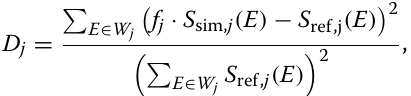
interactions were processed with this CIE map to form an initial spectrum (Eq. 7), the energy calibration parameters were determined, and the energy calibration and resolu- tion applied. The energy resolution parameters were optimised separately from the CIE parameters (inner loop in Fig. 3), as the generation of a new CIE map was by far the most time-consuming step. The same energy calibration was used for all simulated spectra, 177 Lu and MEGP. To enable direct compari- and was determined using the simulation of son of measured and simulated spectra, energy calibration was also made for the meas- ured spectra to ensure consistent photopeak positioning, which otherwise varied slightly depending on the detector temperature at measurement [11, 33]. The simulated spectra were scaled to correspond to the same activity and acquisition time as the corresponding measured spectra, and the level of agreement was determined according to 2 f j · S sim, j ( E ) − S ref,j ( E ) E ∈ W j D j = (cid:31) (cid:29) (cid:30) (10)